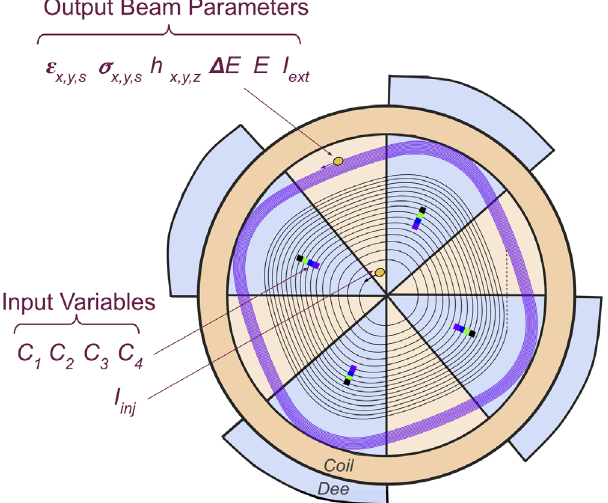
FIG. 12. The IsoDAR schematic, showing an overlay of the magnetic field configuration (coil and dee) and central particle trajectories from the simulation. The rf system used for accel- eration is not shown. In black, the centroid trajectories of 18 turns are shown. A particle bunch of intensity I is injected at the inj center and passes through four families of collimators (indicated with the colored rectangles starting at turn 6). Each collimator family has one parameter C 1 … C 4 defining the collimator aperture. The collimator aperture and the initial intensity are input variables used by the optimizer. In this schematic, the extraction system is not shown, nor are all 100 turns of the beam. The last ten turns before extraction are indicated in purple, together with the output beam parameters: the halo parameters h , the beam size σ , the projected emittance ϵ , beam x;y;z x;y;s x;y;s energy E, and energy spread δ E, and the extracted beam current − I I . Particle losses ( I ) in the collimators have to be ext inj ext minimized, and a small h is desired. This is one of the most important considerations in the design